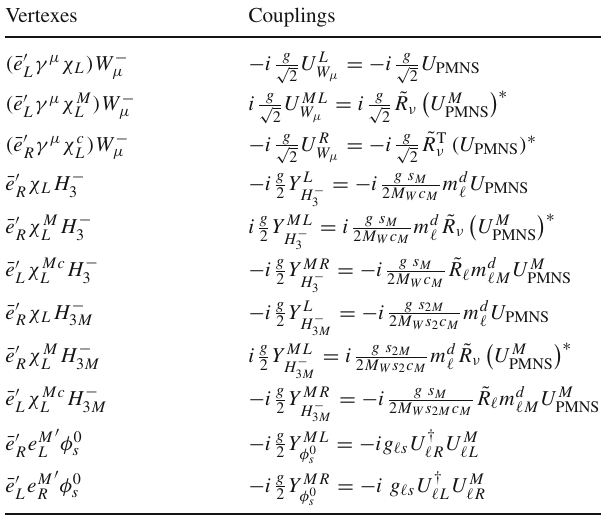
Table 2 Vertexes that contribute to the (cid:4) → (cid:4) (cid:11) γ decay rates in the